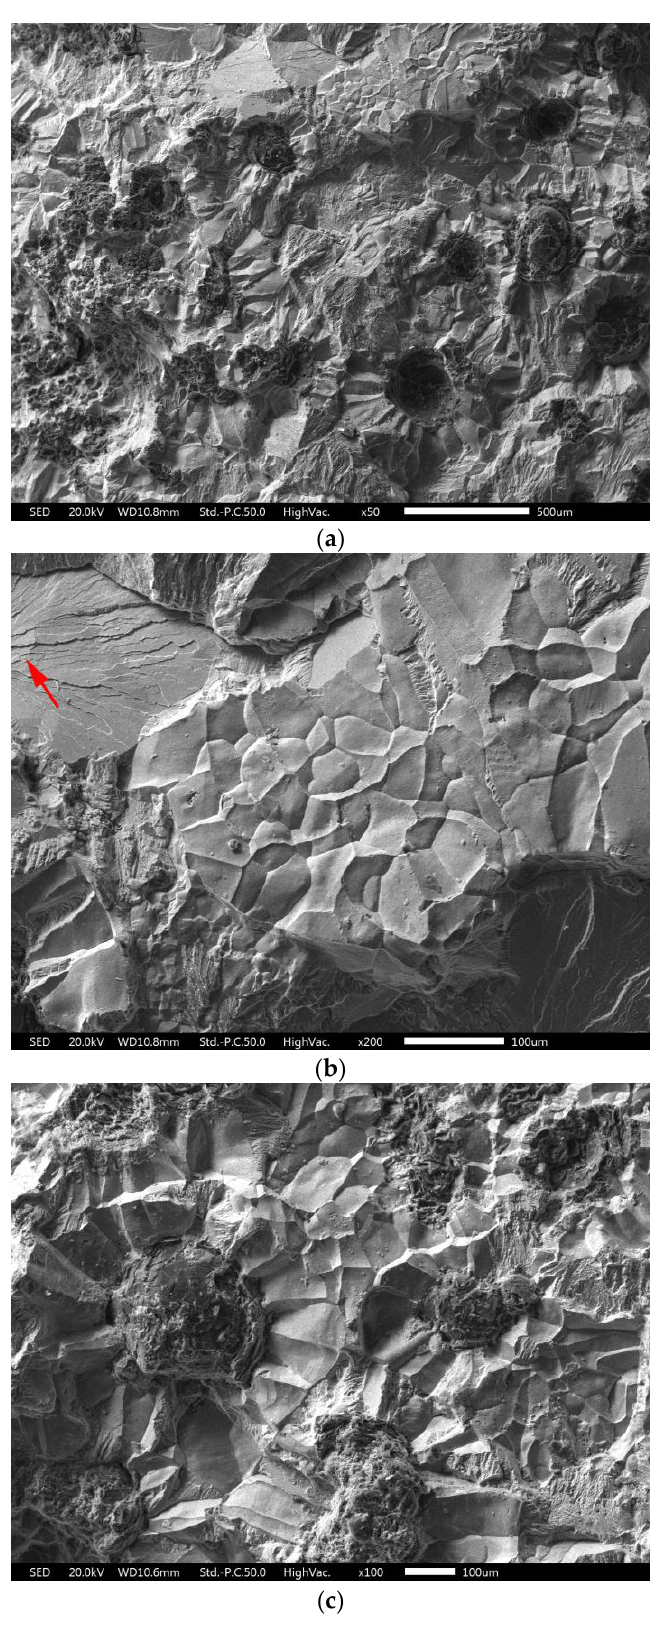
Figure 8. scanning electron microscope (SEM) micrographs of the fatigue fracture surfaces of the C(T) sample tested at R = 0.1: ( a ) overview of the near-threshold crack propagation region; ( b ) detail of cleavage (marked by an arrow) and intergranular fracture; and ( c ) detail of a graphite spheroidal nodule. Crack propagation from top to bottom.